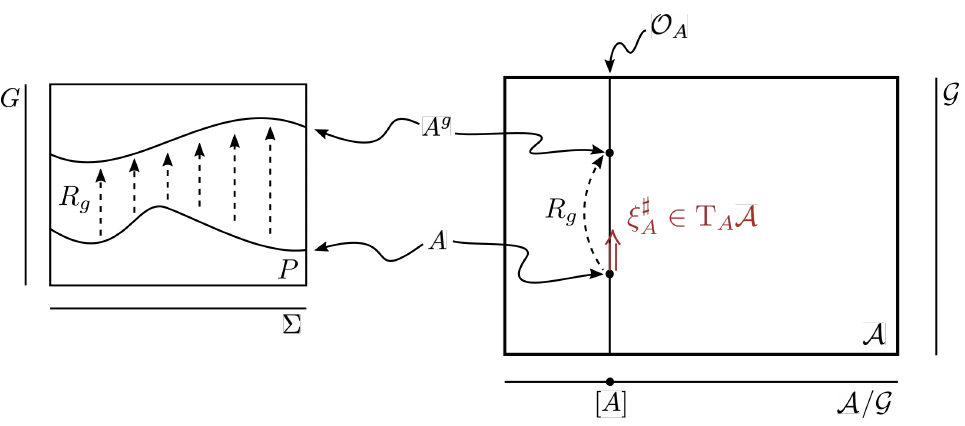
Figure 1: A pictorial representation of the configuration space A seen as a principal fibre bundle, on the right. We have highlighted a generic configuration A , its (gauge- ∼ = G . We have transformed) image under the action of R : A (cid:55)→ A g , and its orbit O g A also represented the quotient space of ‘gauge-invariant configurations’ A / G . On the left hand side of the picture, we have “zoomed into” a representation of A and A g as two gauge-related local sections of a connection ω on P , the finite dimensional principal fibre bundle with structural group G over R . The principal fibre bundle picture of A will be partially revisited in section 4—see figure